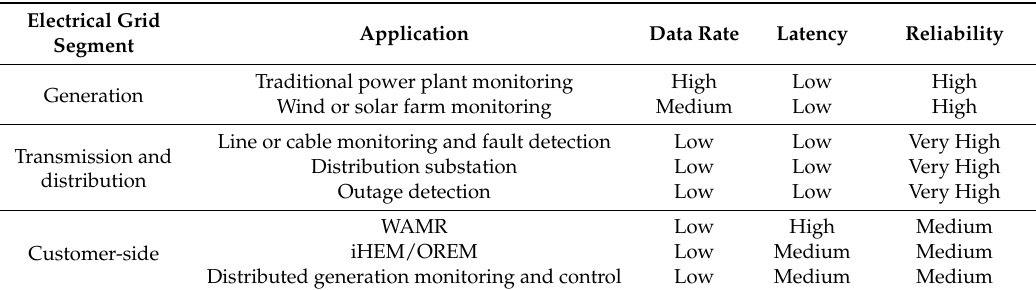
Table 1. Potential WSAN applications for SG and MG